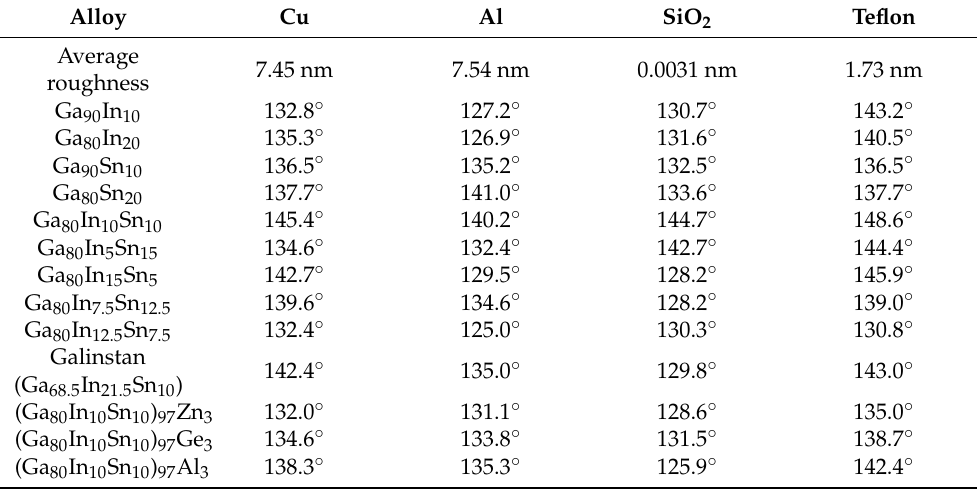
Table 3. Contact angles of di ff erent gallium-based alloys on di ff erent plates at 20 °C.